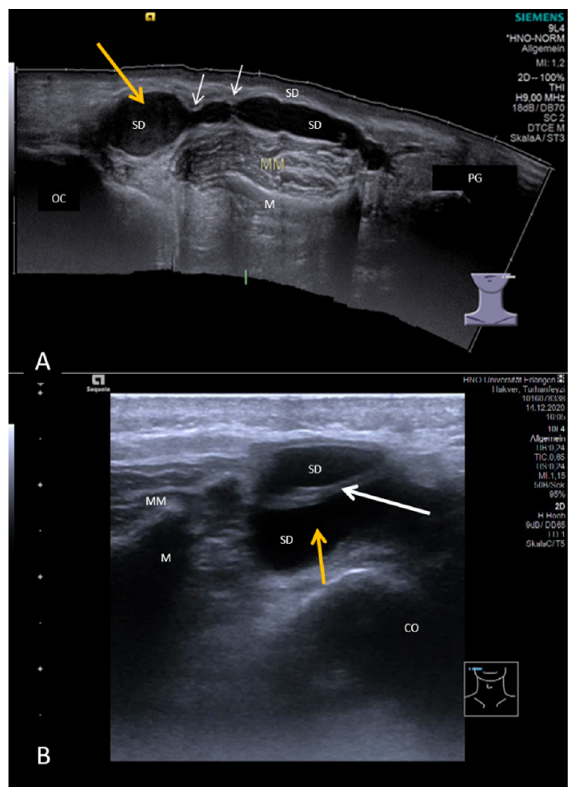
Figure 9. ( A , B ) Duct stenosis with ductal variations in a left ( A ) and a right ( B ) PG. The stenosis is nearly always located distally. The distal duct diameter is often massively increased to more than 10 mm (yellow arrows) in the context of a megaduct. The stenotic effect is caused by a more or less pronounced duct stenosis in the distal duct in combination with ductal abnormalities like pronounced-to-extreme duct kinks observable in sialendoscopy (connective tissue, white arrow, B ) or circular and semicircular encroachments (connective tissue, white arrows ( A )). The diameter of the duct can be very variable during its anatomical course. A tendency to form a megaduct may be observable up to the intraparenchymal duct system, which may have a polycystic aspect here. The parenchyma of the PG is mostly slightly hyperechoic and does not appear changed in a pathological way. Abbreviations: PG, parotid gland; M, mandible; MM, masseter muscle; SD, Stensen’s duct; OC, oral